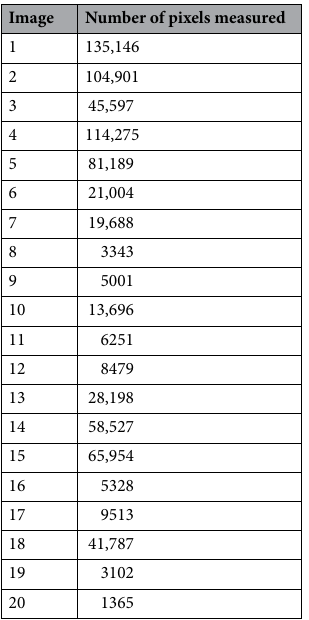
Table 1. Measurement of the extracted regions by using our proposed MCAE approach.